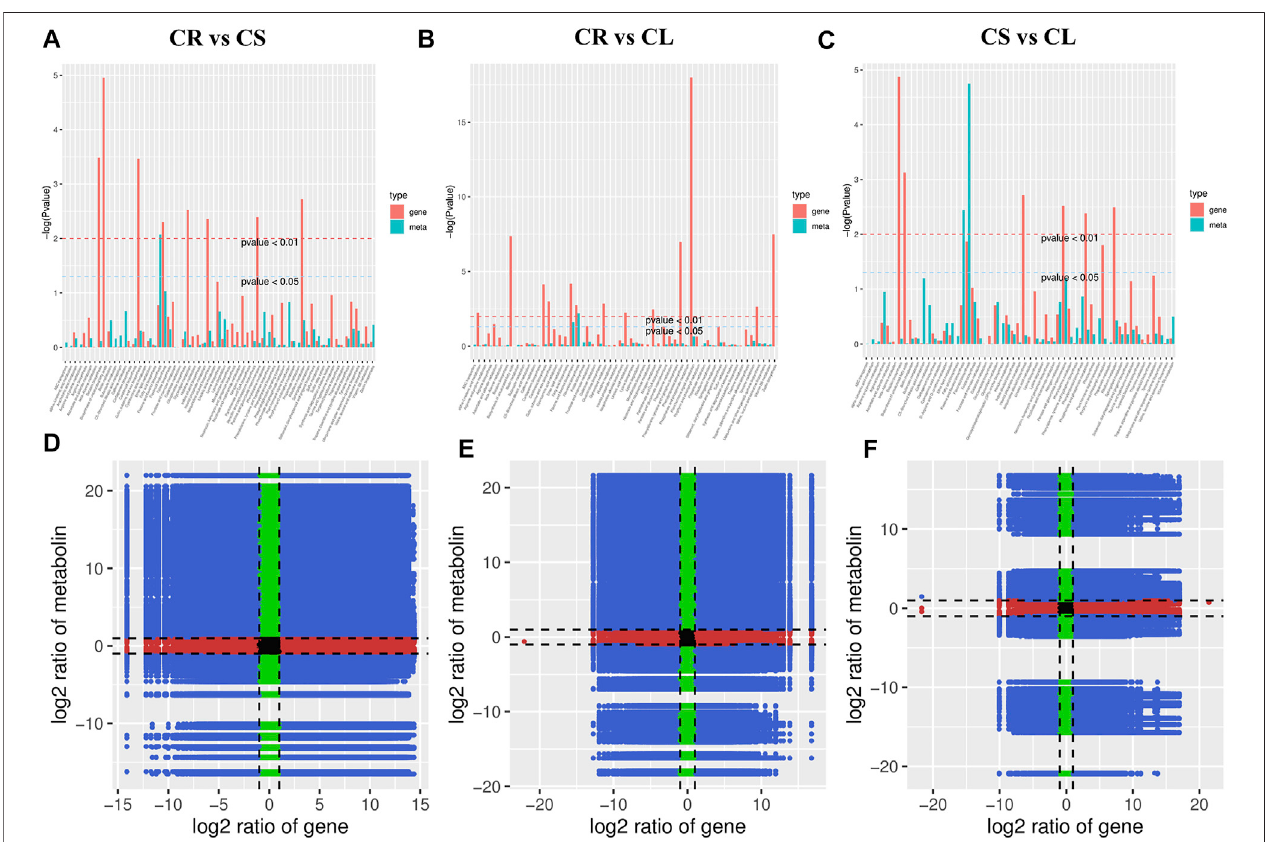
FIGURE7| Combinedanalysesofdifferentiallyexpressedgenesandaccumulatedmetabolites. (A – C) KEGGenrichment p -valuehistogramsand (D – F) Pearson ’ s correlation coef fi cient of genes and metabolites represented as nine-quadrant fl at diagrams. Black dots = unchanged genes/metabolites, green dots = DAMs with unchanged genes, red dots = DEGs with unchanged metabolites, blue dots = DEGs and DAMs. The Pearson ’ s correlation coef fi cient is > 0.8 throughout the nine- quadrant graphs.